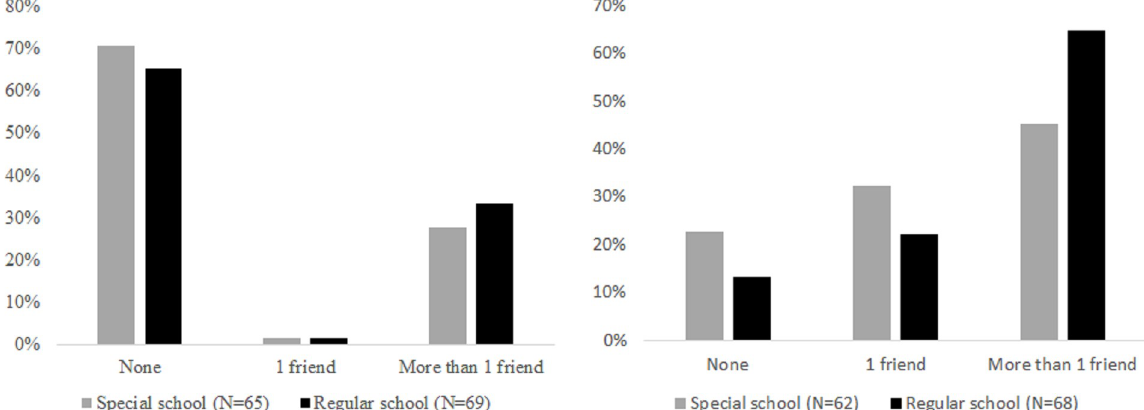
Fig 3. a. Friends not at school, by school type. b. Friends at school, by school type.